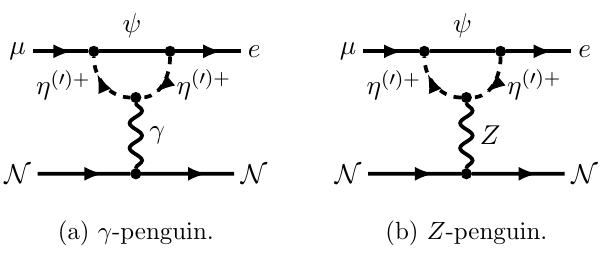
Figure 4 . Diagrams contributing to (cid:22)